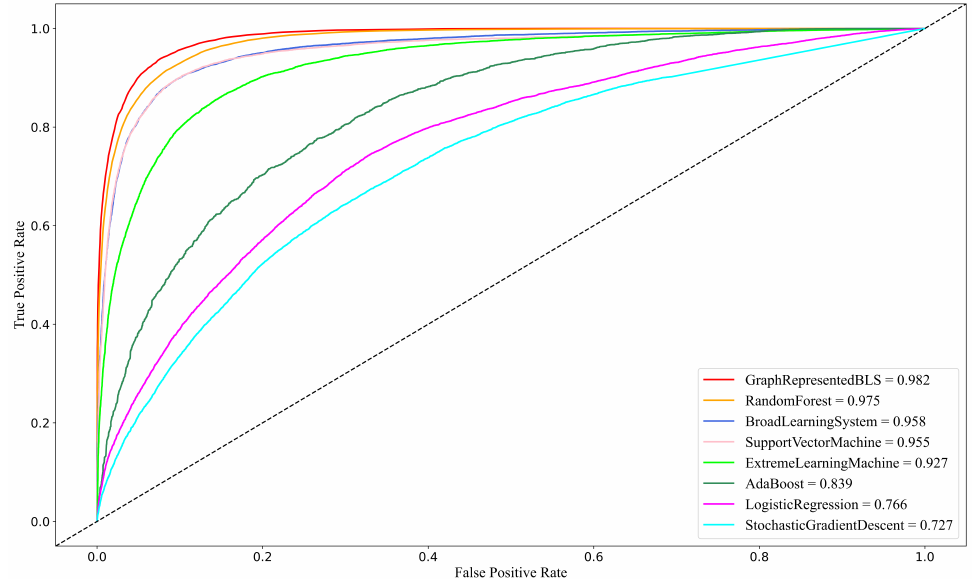
Figure 8. ROC curves of models.